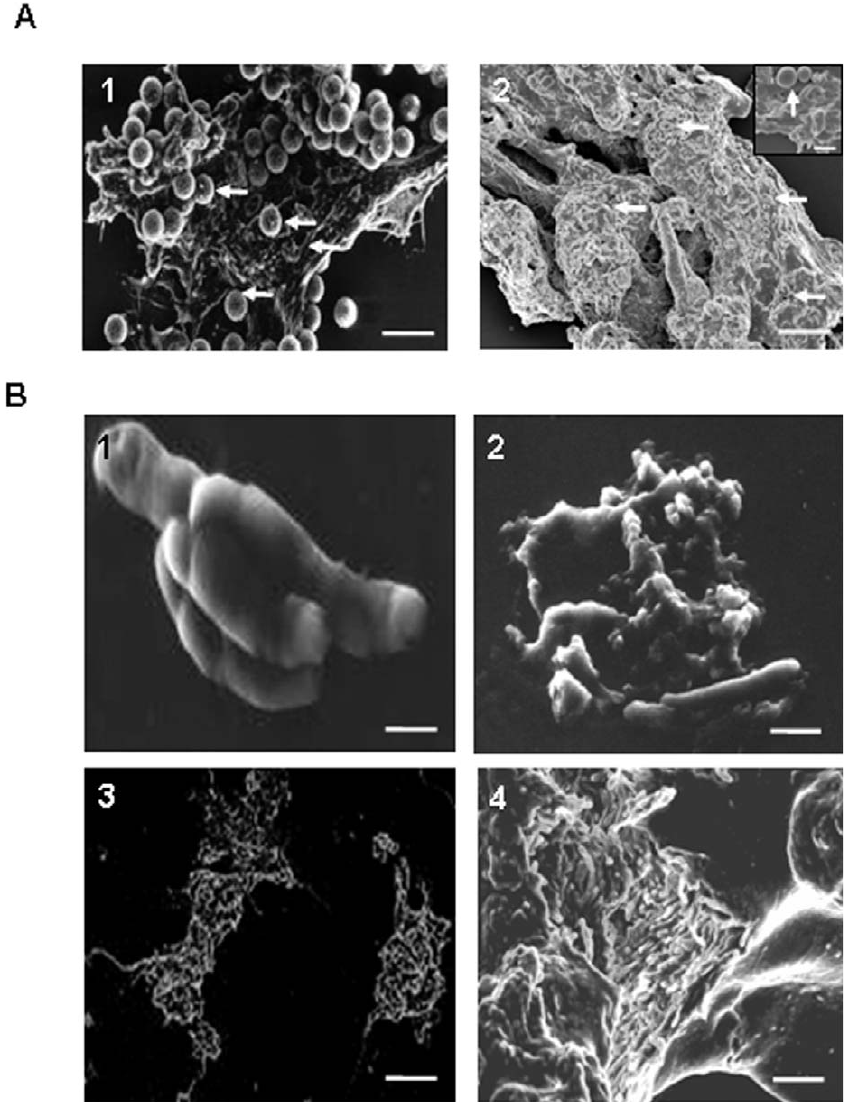
Figure 1. M. ulcerans ECM and Its Formation (A) Scanning electron micrographs of bacilli isolated by immunomagnetic beads separation from mammalian host tissues. Bacilli isolated from human (1) or mouse (2) tissue formed large clusters that are surrounded by ECM. Arrows indicate the immunomagnetic beads. Scale bar: 10 l m (1 and 2), 1 l m (inset). (B) Scanning electron micrographs of cluster formation by M. ulcerans . (1) Ten days after inoculation in 7H9 culture medium supplemented with OADC and containing Tween 80 0.05%, some bacilli formed a small cluster. (2) After 20 d, the bacilli had multiplied and the clusters were covered by extracellular material. (3) At the end of exponential growth (45 d after inoculation) a large cluster was formed (4), which was surrounded by the ECM. Scale bars: 1 l m (1), 1.5 l m (2), 25 l m (3), and 10 l m